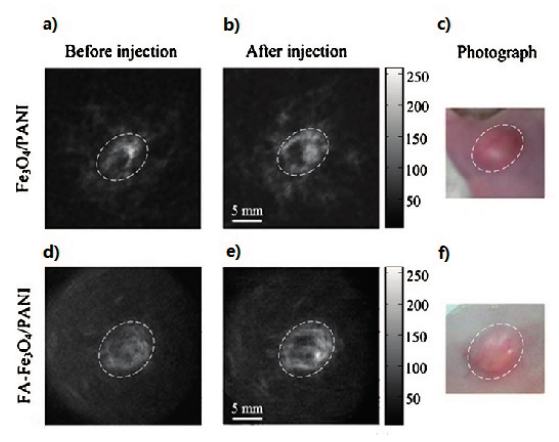
Figure 9. In vivo thermoacoustic imaging of tumors with contrast agent bearing in mouse. ( a , d ) TAT images of control sample injected with PBS; ( b , e ) TAT images of tumor injected with Fe 3 O 4 /PANI and Fe 3 O 4 /PANI-FA, respectively; ( c , f ) Photographs of tumor’s area on the mouse back. (Reprinted from reference [65]. Copyright with permission from © 2010 Am. Assoc. Phys.